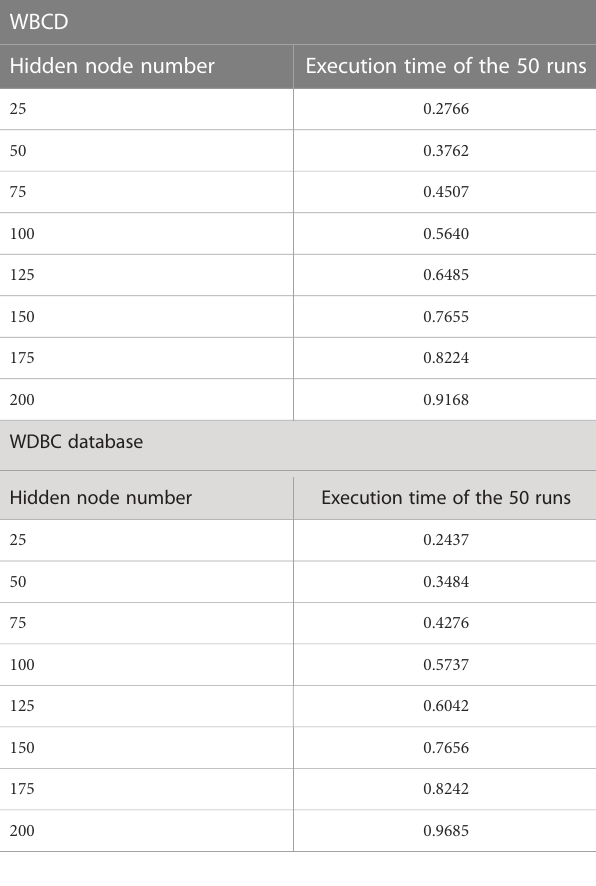
TABLE 10 The comparison of the accuracy rate (the best result) among the methods in diagnosing the BC based on the WBCD and WDBC